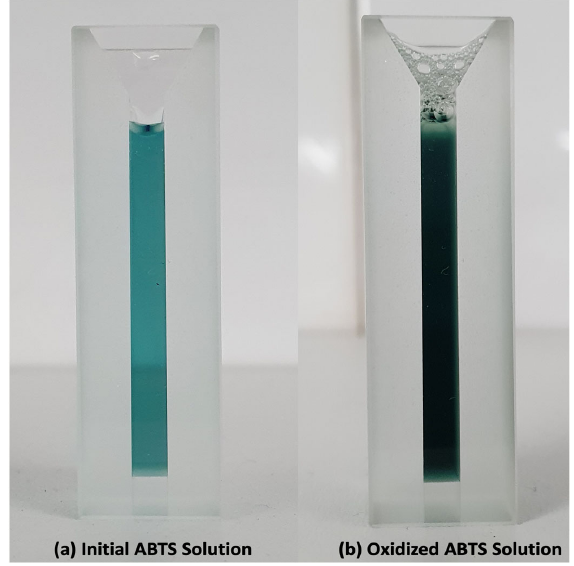
Figure 10. Color changing demonstrated by oxidation of ABTS catalyzed by L Asp . ( a ) Initial ABTS solution; ( b ) oxidized ABTS solution.